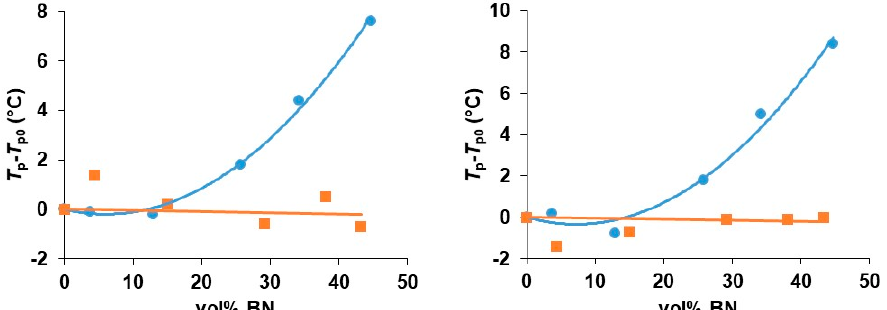
Figure 6. Peak temperature during non-isothermal cure relative to that for the unfilled system, T p − T p0 , as a function of BN 30 µ m content for the heating rates of 2 K / min ( left ) and 5 K / min ( right ). Epoxy-thiol system, blue circles; epoxy-diamine system, red squares.